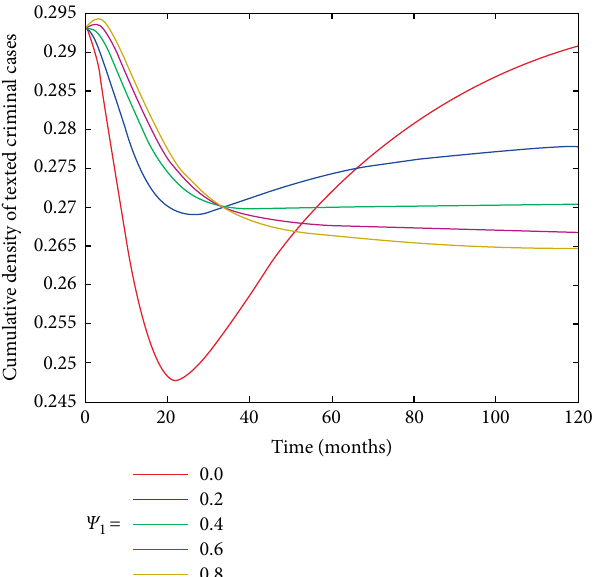
Figure 13: Simulation of model (4) showing the effect of varying the values of on the cumulative density of texted criminal cases as a 𝜓 1 function of time. Other parameter values used are as given in Table 3.